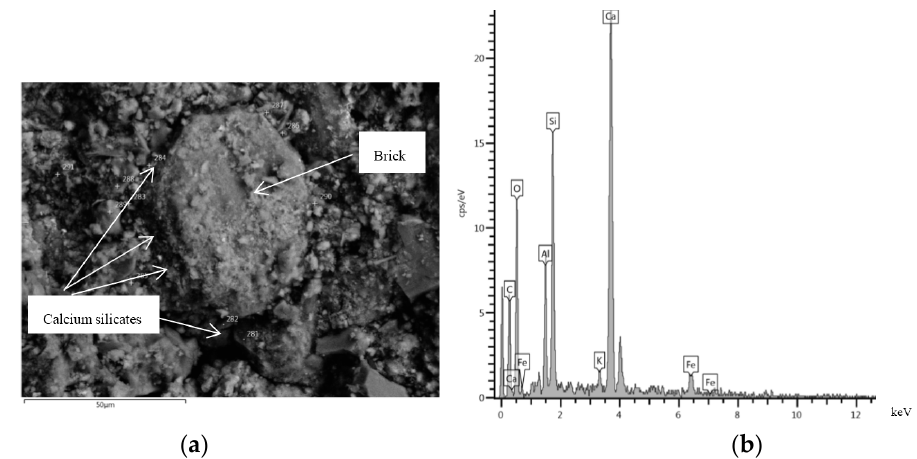
Figure 7. ( a ) SEM micrograph image of MRA; and ( b ) composition of an MRA sample estimated by X ‐ ray spectroscopy.